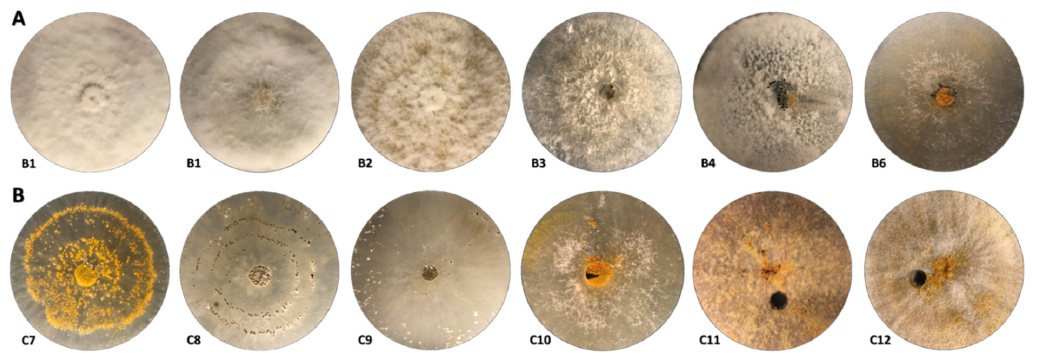
Figure 4. Isolate growth. Of the different isolates from Site B ( A ), the primary color observed was white, a color usually